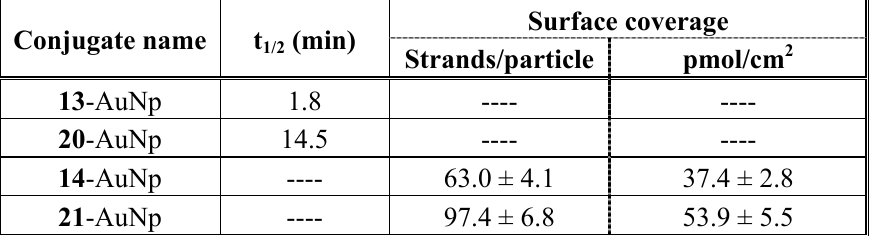
Table 3. Half-lives and surface coverage data for oligonucleotide-gold nanoparticle